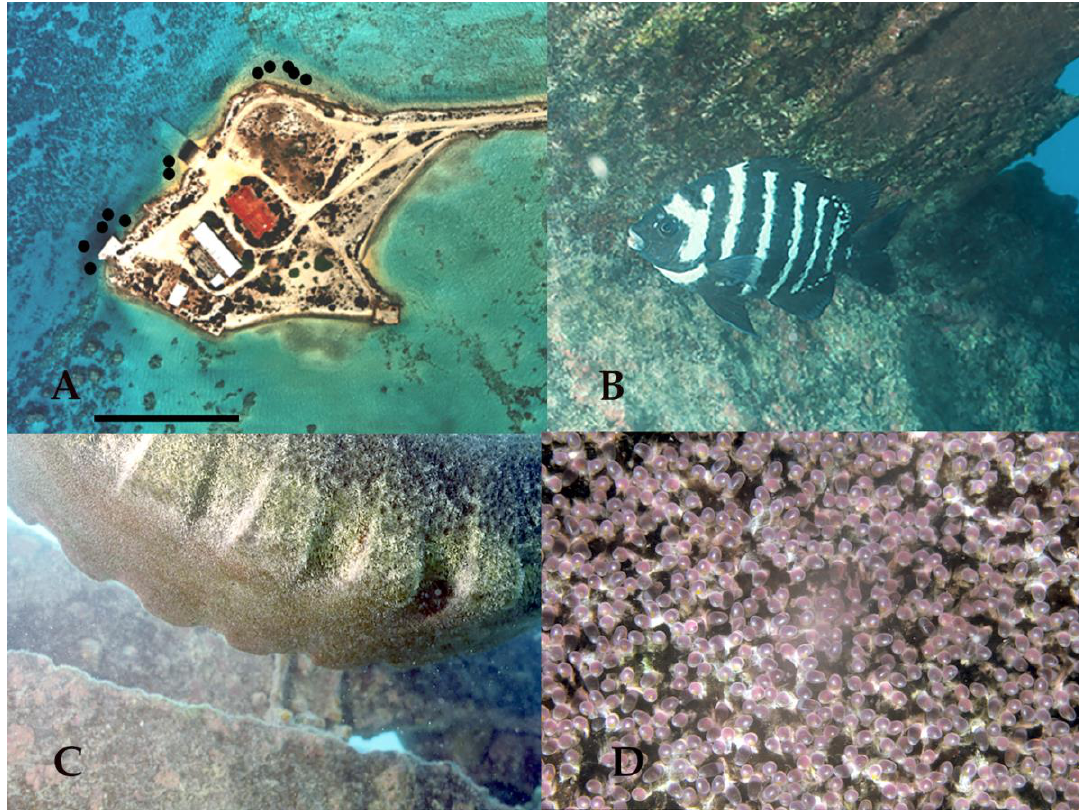
Figure 1. ( A ) Aerial view of the west end of Sand Island with black dots indicating nest site locations. From left to right the nest sites are K, N, Ch1, L, Pipe, H, Z, B, 1, F1, F2, and E1. Clutches in nest sites H and Z were spawned by the same male, as were clutches in sites B and 1. The scale bar indicates 100 m. ( B ) Male defending a clutch of embryos at nest site “F1” . Males only adopt the high contrast black and white coloration during spawning and courtship. The pinkish area in the top right of the photo is the newly spawned clutch. ( C ) Nest site “H” located on a submerged tire. The guardian male has prepared the nest site to receive embryos. ( D ) Macro photograph of newly spawned embryos. Embryos are 1 mm in length.